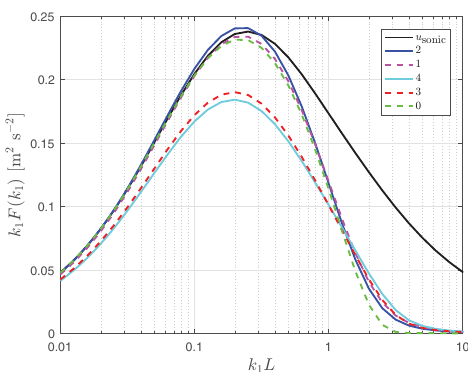
Figure 5. Effect of lidar beam misalignment (with respect to the wind) on the radial velocity spectra of a pulsed lidar for ϕ = 15 ◦ , Γ = 3 , αε 2 / 3 = 0 . 1m 4 / 3 s − 2 , z R /L = 0 . 5, and β = − 2 ◦ .